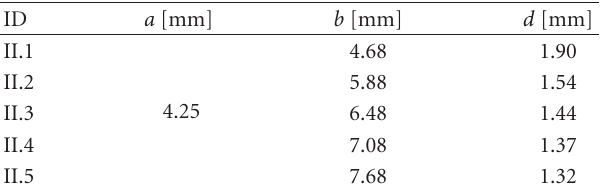
Table 2: Second set of DRA dimensions ( a , b , d ) considered for a rectangular DRA operating in the fundamental TE z 14 . 25